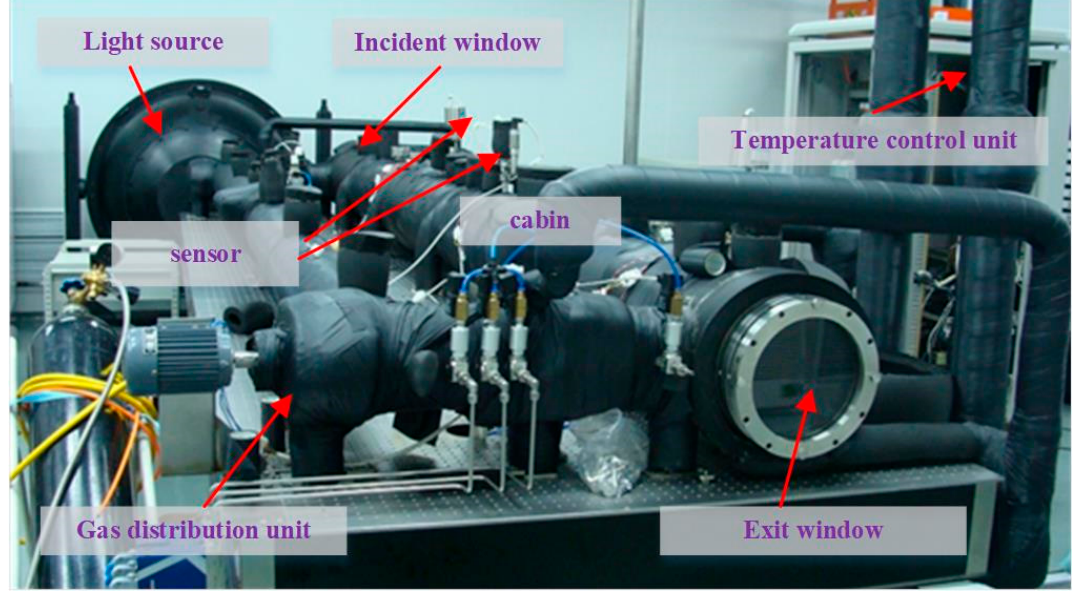
Figure 6. Simulated calibration chamber system of main atmospheric greenhouse